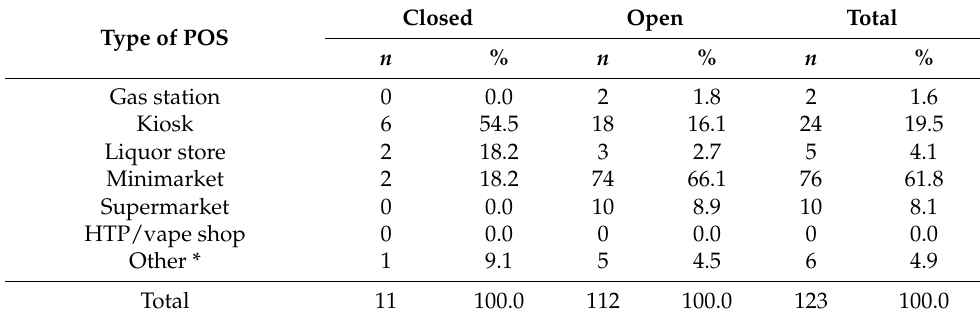
Table 1. Distribution of POS by type and availability for observation.